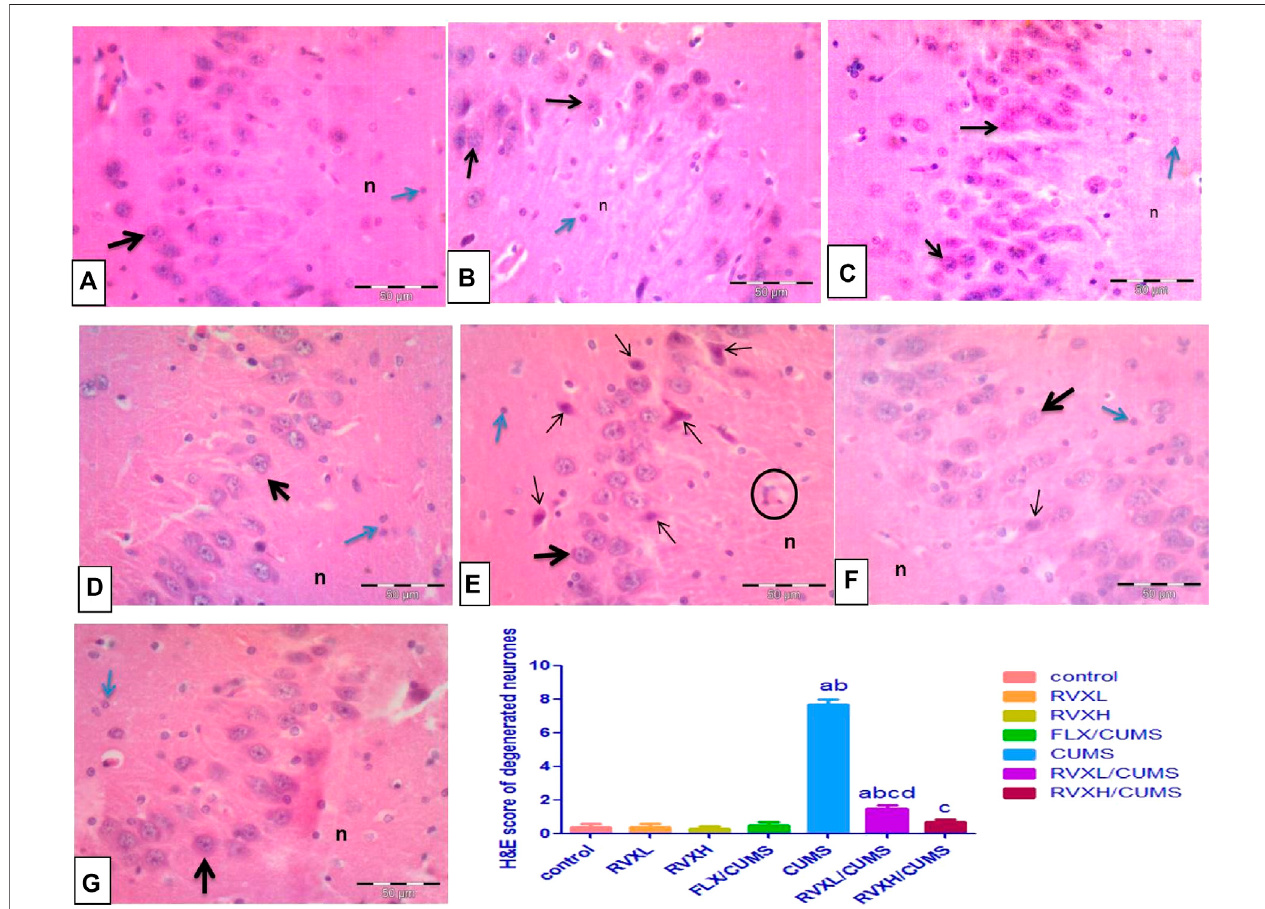
FIGURE 5 | Representative photomicrographs of the CA3 zone of the hippocampus (A –– D) Control, RVXL, RVXH, and FLX groups showing normal densely packed pyramidal neurons with vesicular nuclei and prominent nucleoli (thick arrow), neurophil (n), and glial cells (blue arrow). (E) The CUMS group showing shrunken elongated pyramidal neurons with darkly stained nuclei (thin arrows). The structure in the circle may indicate fused microglia. (F) The RVXL/CUMS group showing a normalmorphologicalappearanceofthepyramidalneurons(thickarrow), whilethethin arrowrevealsashrunkenelongatedpyramidalneuronwithadarklystained nucleus. (G) RVXH/CUMS group showing normal neurons (thick arrow), neurophil (n), and glial cells (blue arrow). H&E x400, scale bars (cid:2) 50 μ m a Signi fi cant difference compared to the control, b signi fi cant difference compared to the FLX group, c signi fi cant difference compared to the CUMS group and d signi fi cant difference compared to the RVXH. p value < 0.0001. CUMS, chronic unpredictable mild stress; FLX, Fluoxetine; RVX L, rivaroxaban low dose; and RVX H, rivaroxaban